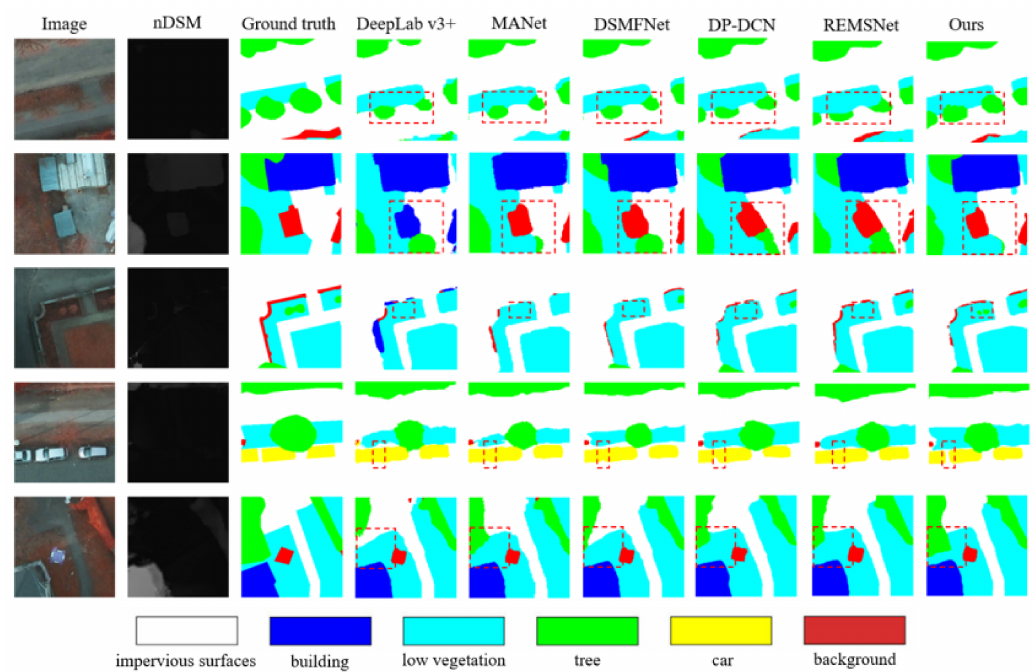
Figure 7. Comparison of experimental results for five images in the Potsdam dataset.